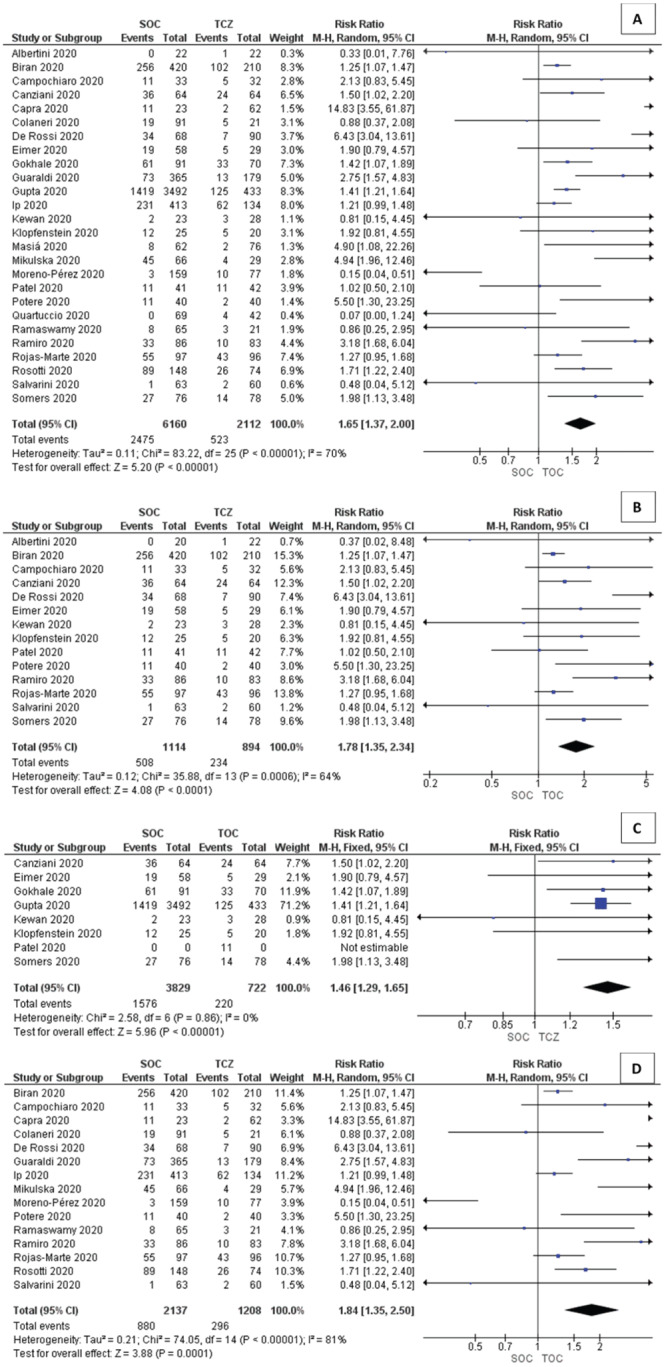
Forest plot outcome between SOC group and TCZ group.
A) All-cause mortality event;
B) Subgroup CRP >100 mg/L;
C) Subgroup PaO2:FiO2 200-300 mmHg;
D) Subgroup PaO2:FiO2 <200 mmHg. SOC, standard of care; TCZ, tocilizumab; CRP, C-reactive protein; SD, standard deviation; CI, confidence intervals.